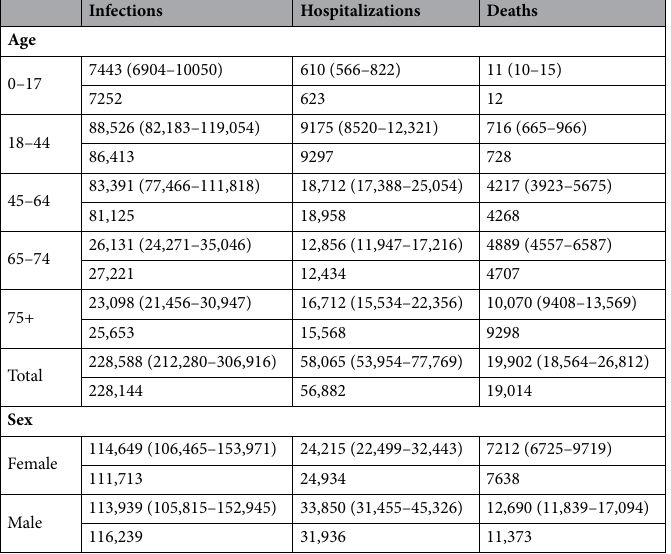
Table 2. Model predictions with 90% CIs (top rows) and reported numbers (bottom rows) of accumulated infections, hospitalization, and deaths for NYC on 21-Aug-2020, by age range and